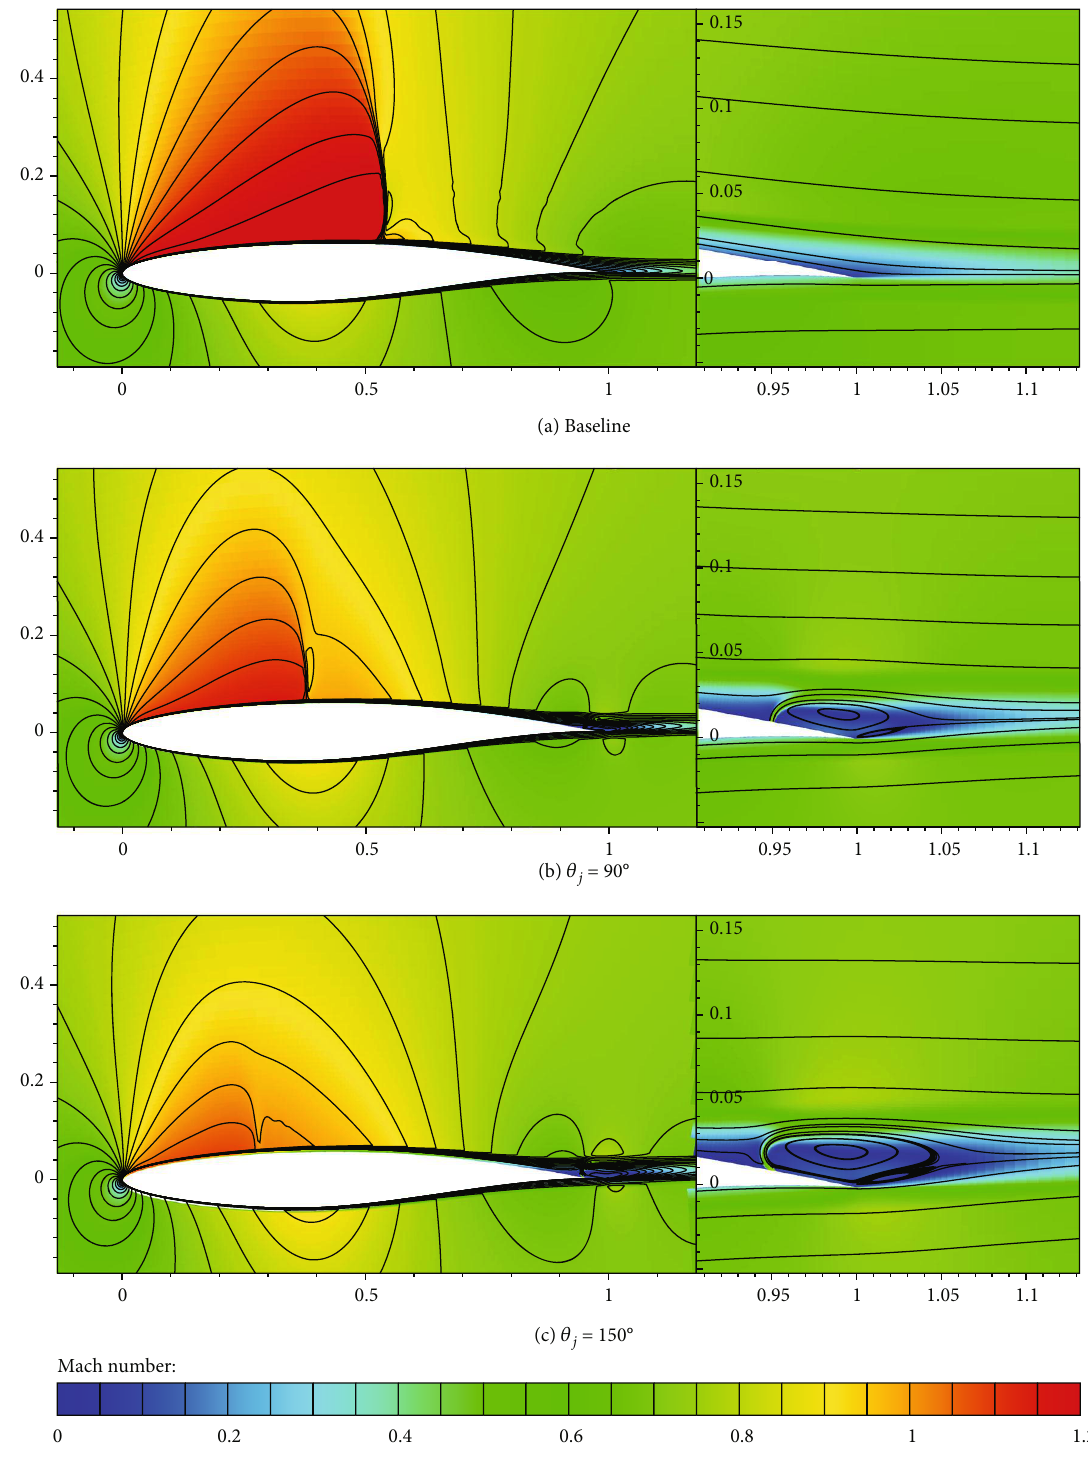
= 0 : 729 , α = 3 ° , and C ∞